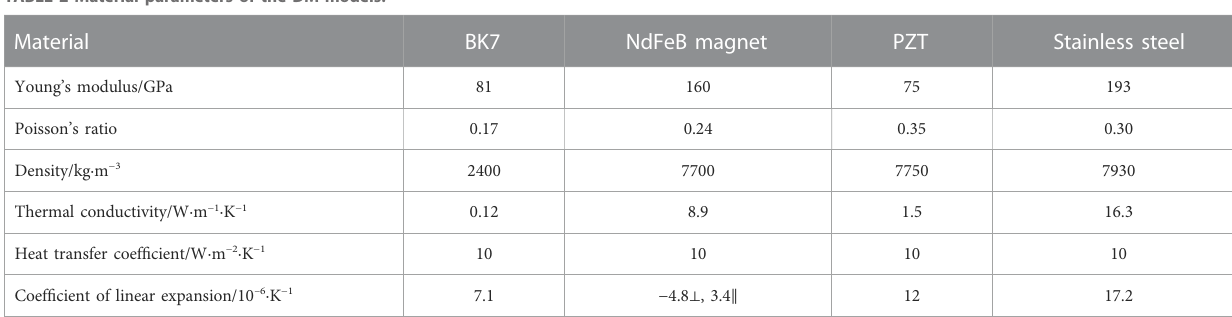
TABLE 2 Material parameters of the DM